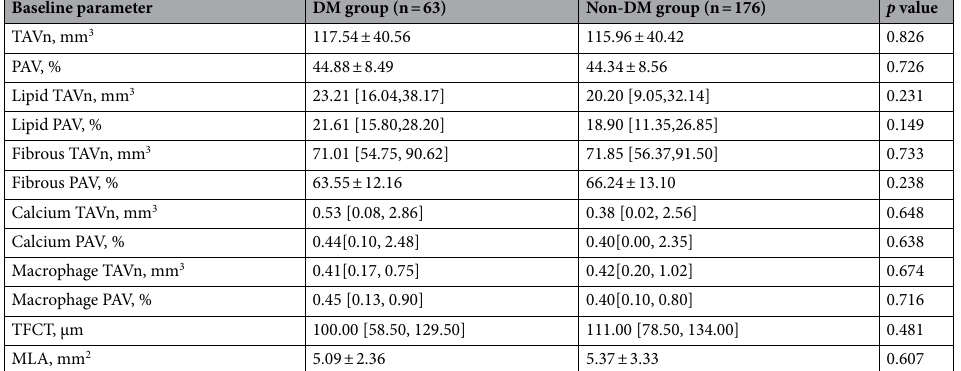
Table 5. nCSA baseline characteristics measured by OFR for patients with or without DM in phase I analysis. Values are expressed as the median (interquartile range) for continuous variables with abnormal distribution and described as the mean ± standard deviation with normal distribution, or frequency (percentage) for categorical variables in the table. DM diabetes mellitus, MLA minimal luminal area, nCSA non-culprit subclinical atherosclerosis, OFR optical flow ratio, PAV percent atheroma volume, TAVn normalized total atheroma volume, TFCT thinnest fibrous cap